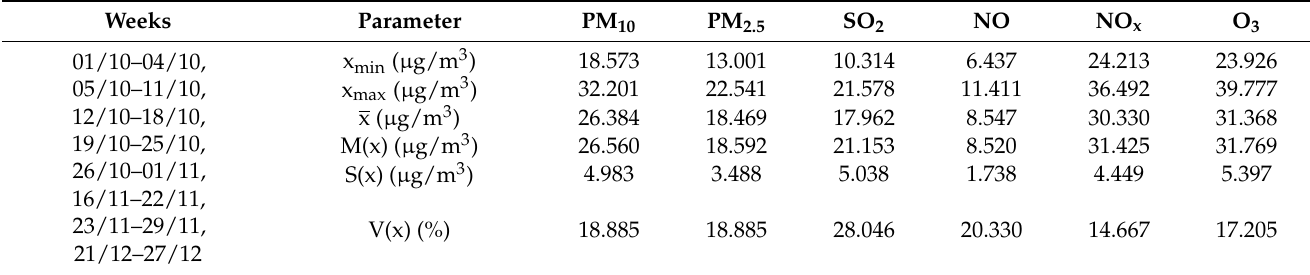
Table 8. Average measures and measures of relative variability for group no.